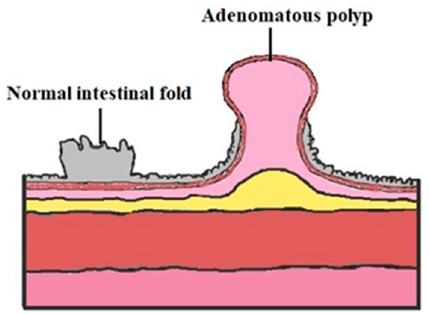
Figure 2. Normal intestinal fold vs. adenomatous colon polyp.